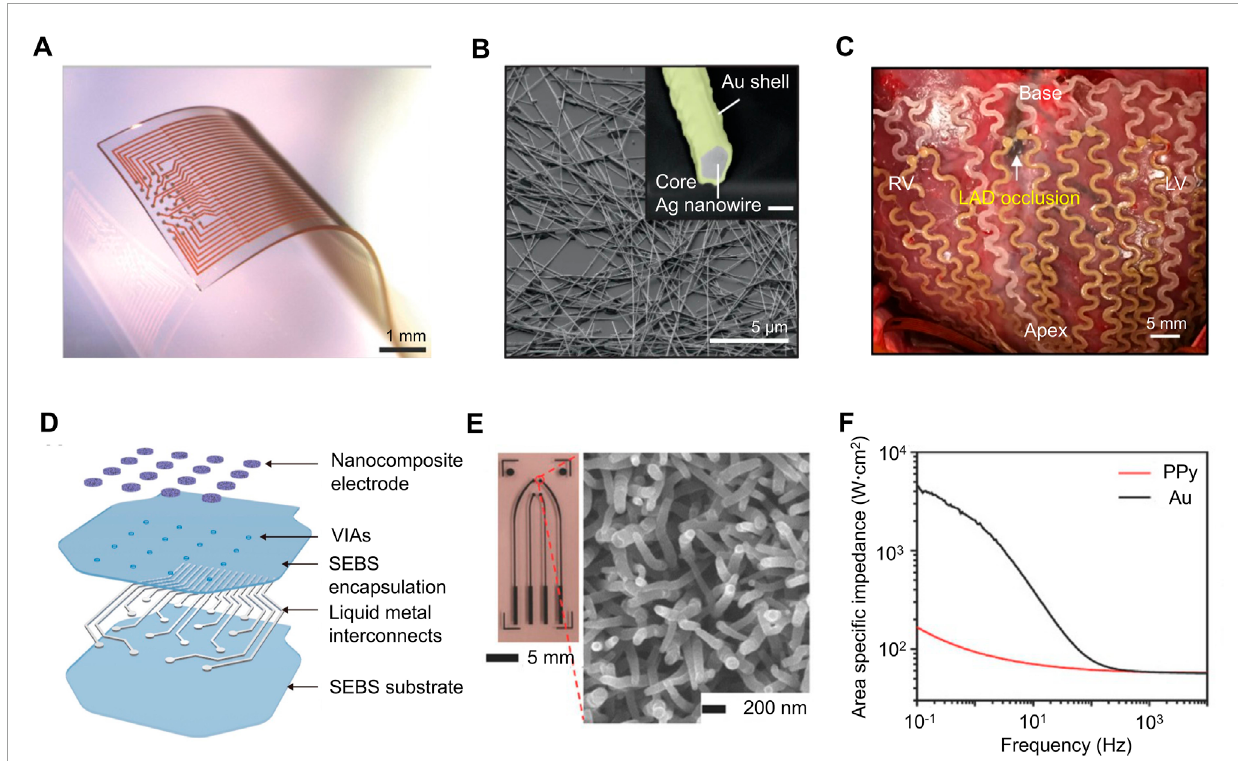
FIGURE 6 (A) Soft and stretchable electrode grids. The electrode grid is based on Au-TiO2NW conductors embedded in PDMS and comprises 32 electrodes with 200 µm pitch. Scale bars: 1 mm. (B) SEM image and backscattered electron (BSE) image (inset) of Ag-Au nanowires (before surface modification; Au sheath is in yellow). Scale bars, 5µm and 200 nm (inset). (C) Ag–Au nanocomposite-based implantable cardiac mesh for monitoring and stimulating swine heart in vivo . (D) Schematic showing the layer-by-layer construction of the liquid metal based electronic patch with nanocomposite electrodes. (E) Optical images of the multielectrode array (left) and SEM image of the PPy nanowires synthesized on the PPy electrode surface (right). (F) Electrochemical impedance spectra of the PPy film and Au film electrodes with the same geometric surface area. [adapted and modified from (Qi et al., 2017; Choi et al., 2018; Tybrandt et al., 2018; Wang S. et al.,